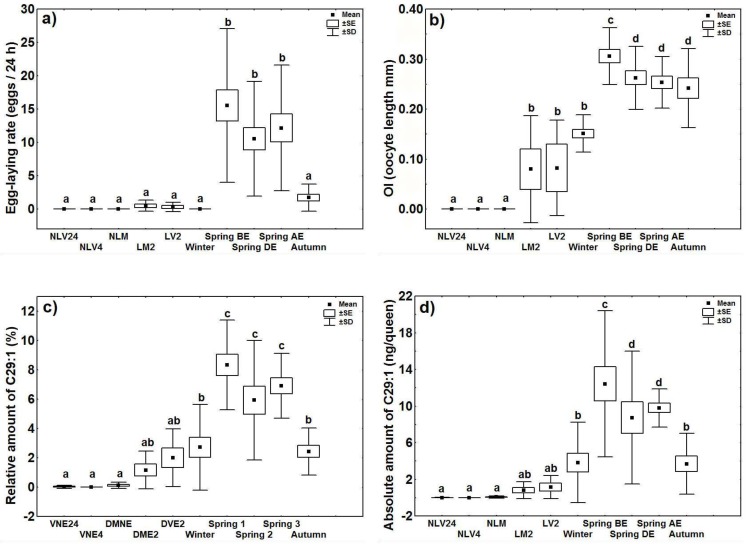
Fertility and CHC quantities in invasive queens according to reproductive status and season.(a) egg-laying rate; (b) ovarian index (OI); (c) relative amount of C29:1; and (d) absolute amount of C29:1. All queens were fertilized except those marked as virgins. The abbreviations for reproductive status are as in Fig 1. The following additional abbreviations were used: queens collected in February (Winter) (n = 19); queens collected before the execution period (Spring BE) (n = 17); queens collected during the execution period (Spring DE) (n = 18); queens collected after the execution period (Spring AE) (n = 17); and queens collected in September (Autumn) (n = 15).